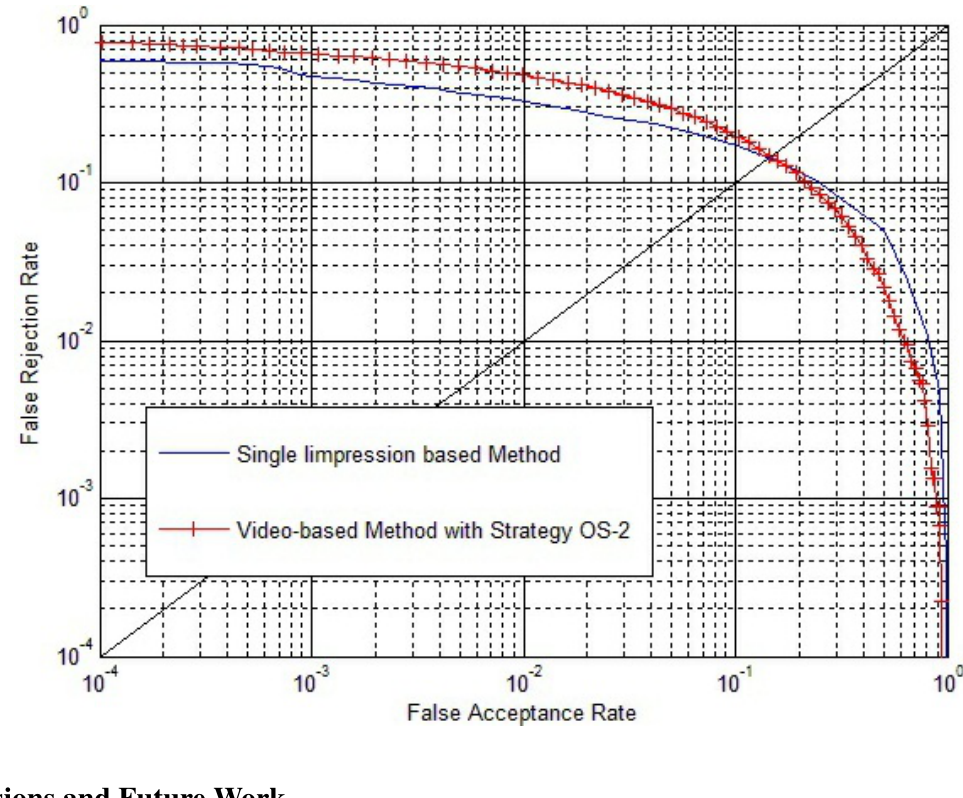
Figure 18. ROC of the single impression-based method and the video-based method with Strategy